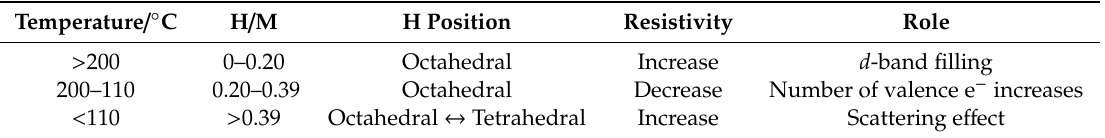
Table 1. The hydrogen position in the Pd 79 –Ag 21 lattice vs. H / M, temperature, related role, and resistivity